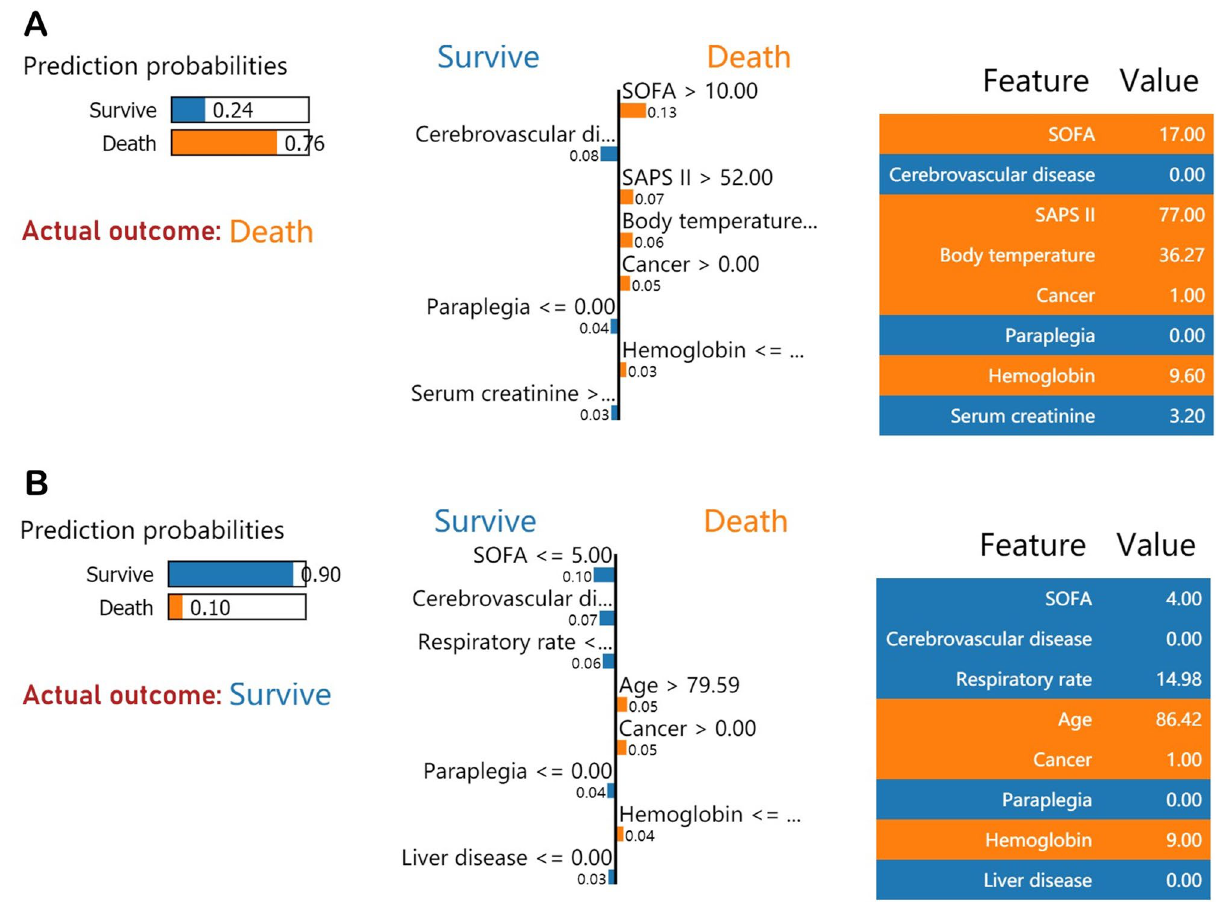
Figure 6. LIME algorithm for explaining individual’s prediction results. Screenshot of the death prognosis for SA-AKI patients. ( A ) Utilizing the LIME method, show a death case. ( B ) Present a case of survival using the LIME method. The left portion of the picture depicts expected LIME findings. The center section lists, from highest to lowest, the eight variables that had the greatest impact on survival or death. The length of the bar for each feature reflects the weight of that feature in the prediction. A longer bar represents a characteristic that contributes more to survival or mortality. The right panel displays the crucial values of these eight factors at which they had the greatest influence on survival or death. SA-AKI Sepsis-associated acute kidney injury, SOFA Sequential organ failure assessment, SAPS II Simplified acute physiology score II, SpO 2 Oxygen saturation, PTT Partial thromboplastin time, WBC White blood